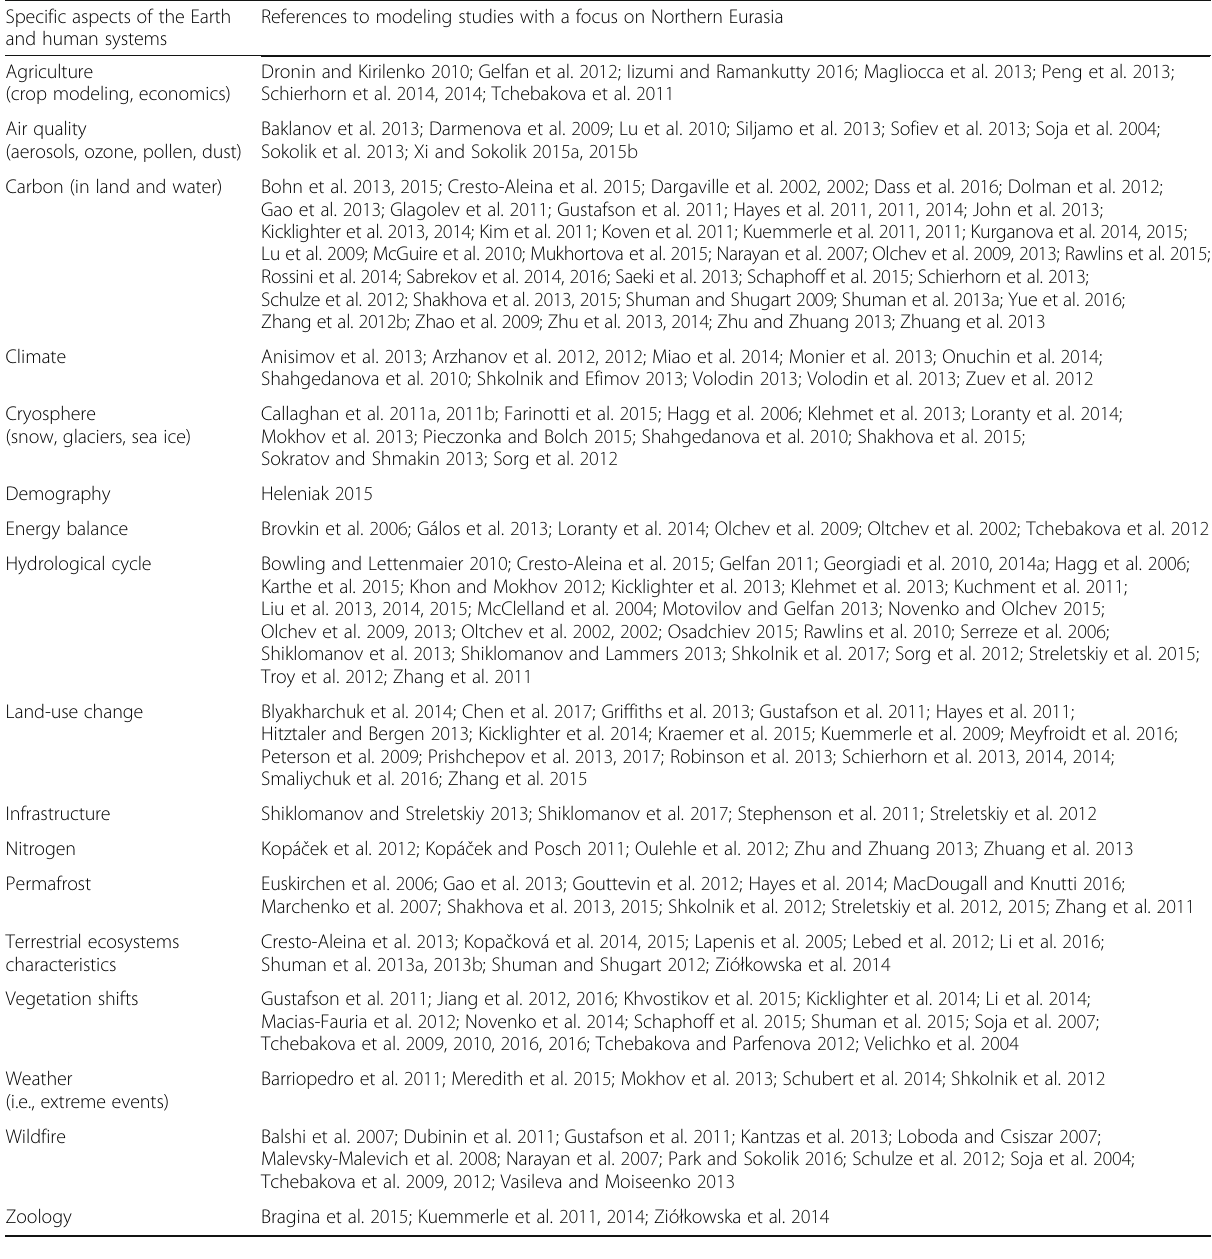
Table 1 Non-exhaustive list of modeling studies with a focus on Northern Eurasia. The list is sorted by specific aspects of the Earth and human systems. Some studies are listed under several aspects of the Earth and human systems. From Monier et al. (2017